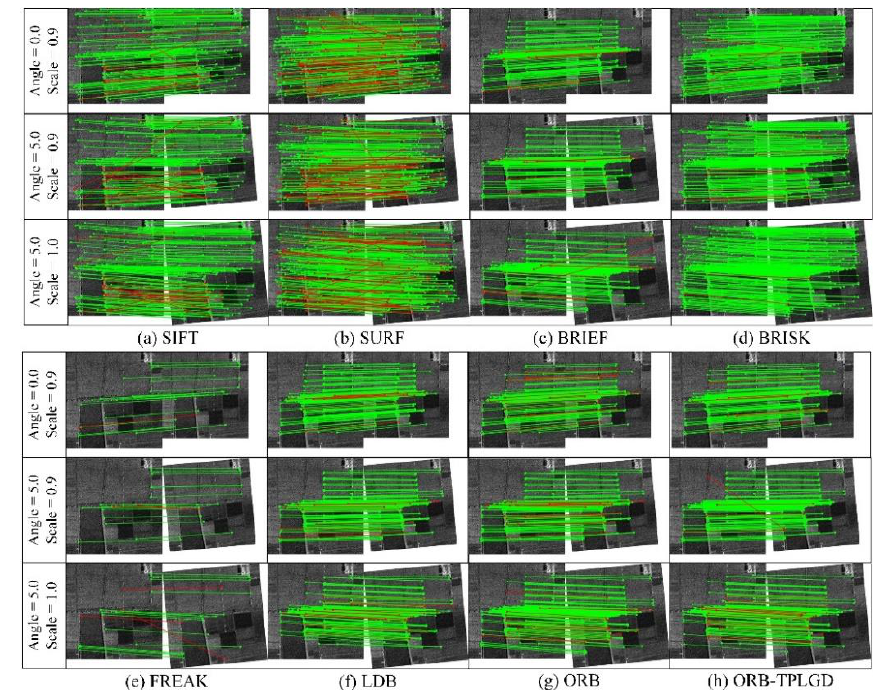
Figure 12. Matching effect based on the selected SAR images. ( a ) SIFT, ( b ) SURF, ( c ) BRIEF, ( d ) BRISK,